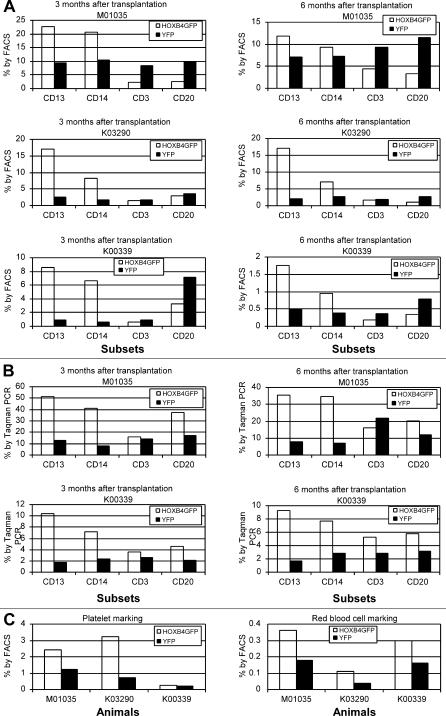
Differential Effects of
HOXB4 Overexpression on Granulocyte and Lymphocyte Engraftment and Marking Levels in Platelets and Red Blood Cells
(A) Flow-cytometric analysis of CD13
+, CD14
+, CD3
+, and CD20
+ cells in peripheral blood of M01035, K00339, and K03290 at 3 and 6 mo after transplantation.
(B) HOXB4GFP or YFP marking levels of FACS-sorted CD13
+ myeloid cells, CD14
+ monocytes, CD3
+ T cells, and CD20
+ B cells from peripheral blood of M01035 and K00339 at 3 or 6 mo after transplantation as determined by Taqman PCR.
(C) Representative flow-cytometric analysis of marking levels in platelets and red blood cells at 3 mo after transplantation for M01035, K00339, and K03290.